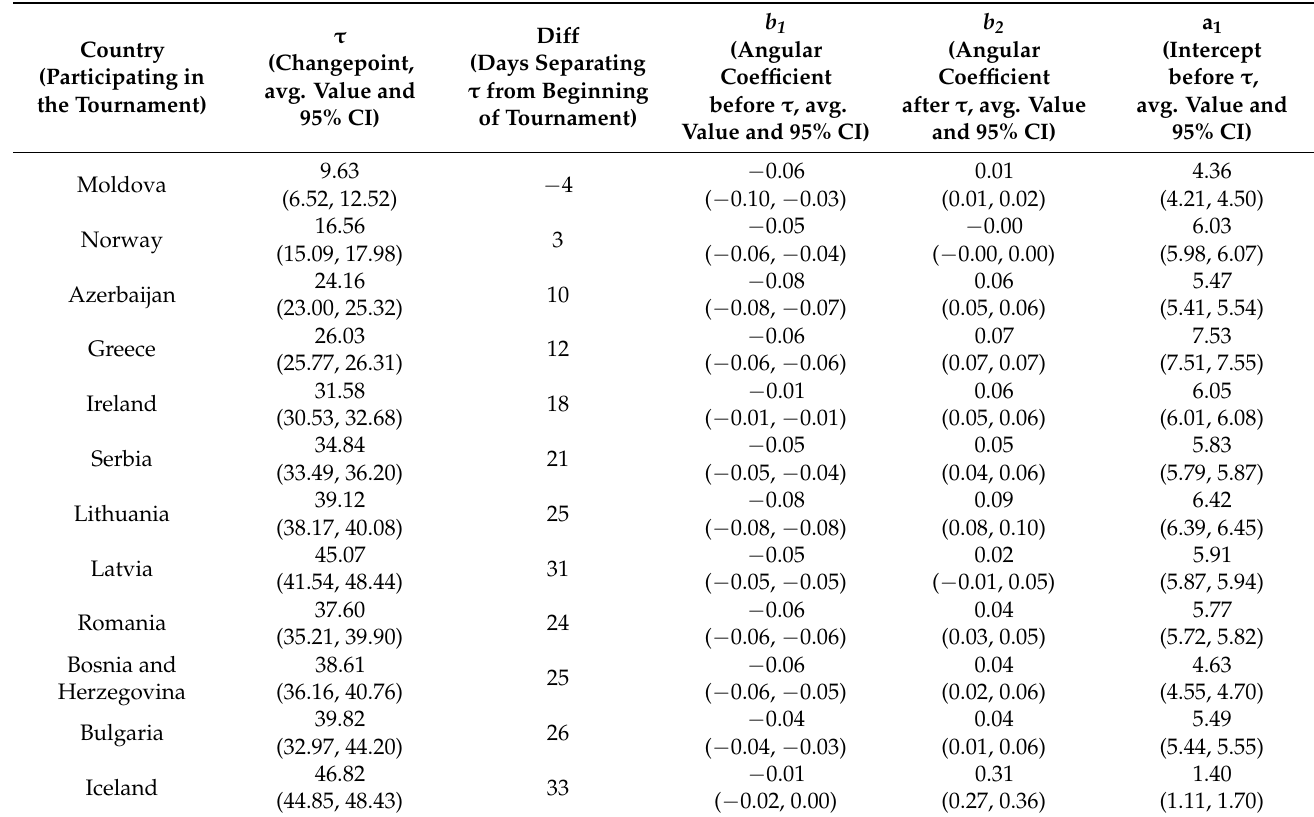
Table 4. Regression parameters for some 12 countries that did not participate in the tournament.